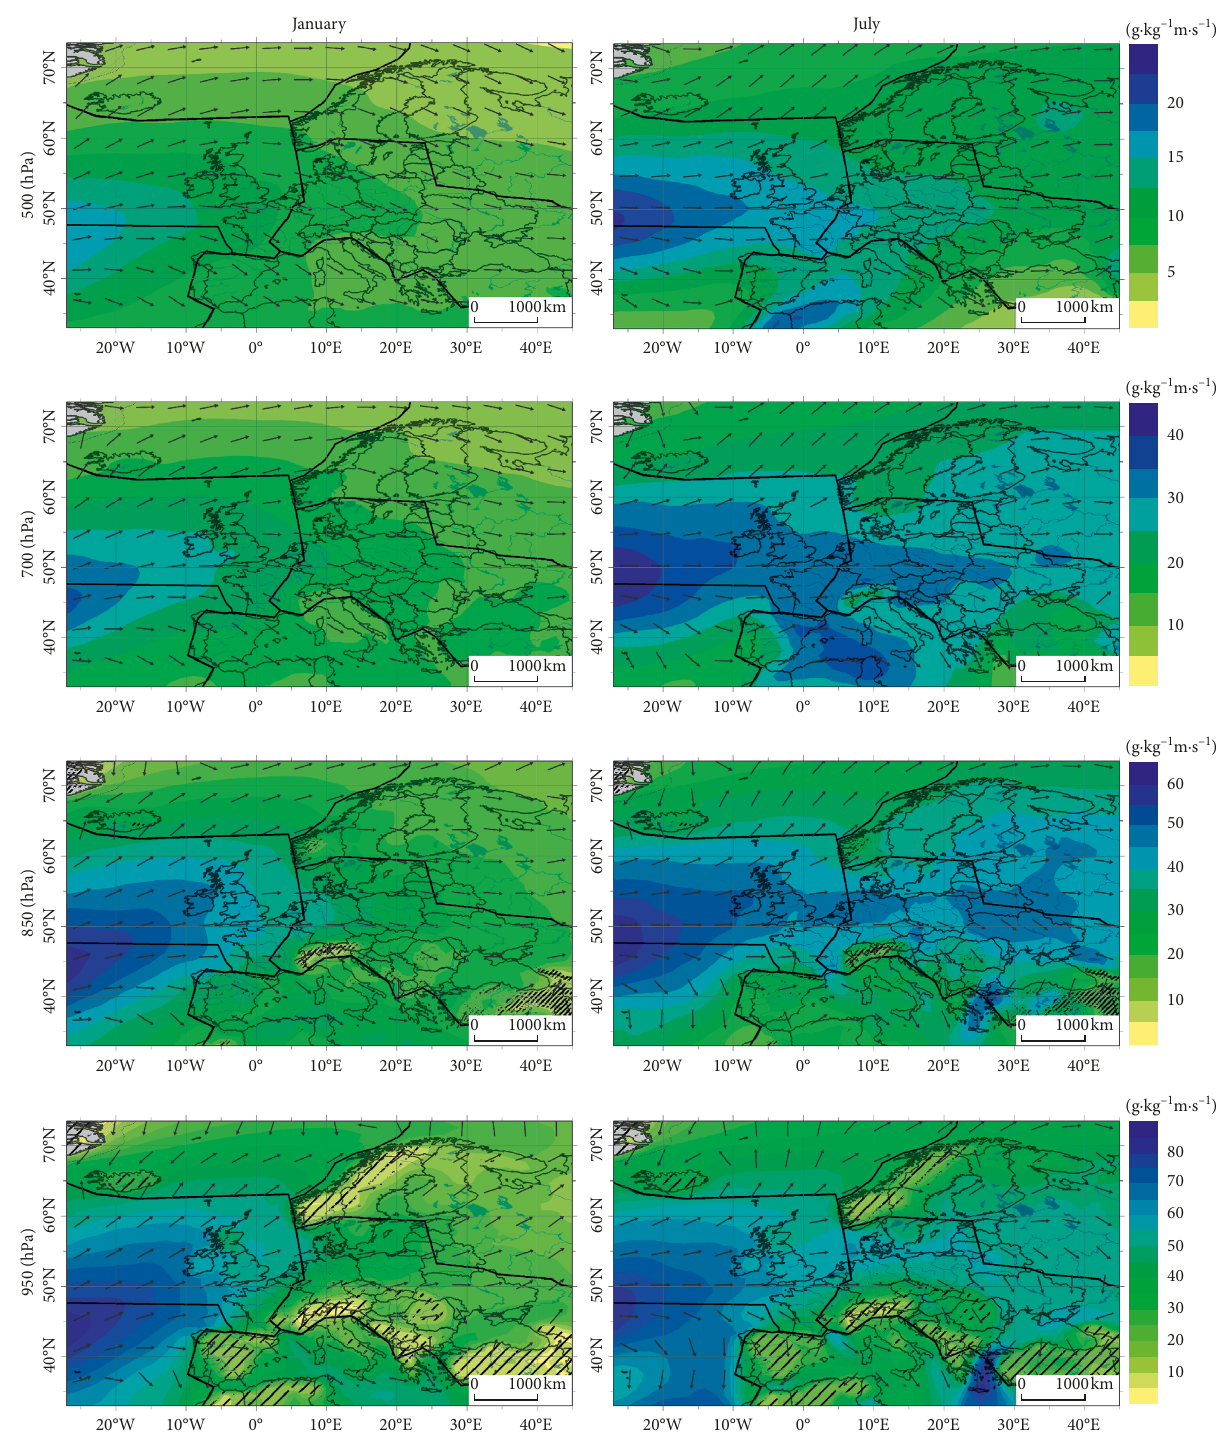
Figure 9: Monthly mean specific humidity flux and wind direction (arrows) at selected pressure levels (1981–2015); slanted lines are used to denote areas situated above the average of selected pressure